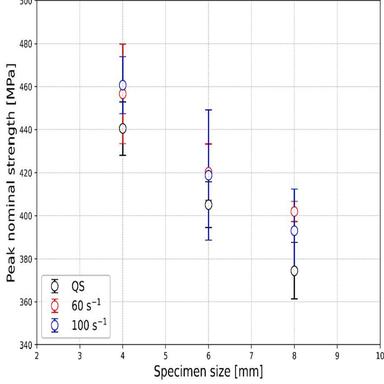
Peak nominal stress (σu) variation with characteristic specimen size (w) measured at different loading rates from the quasi-static (QS) up to strain rate of 100 s − 1 .